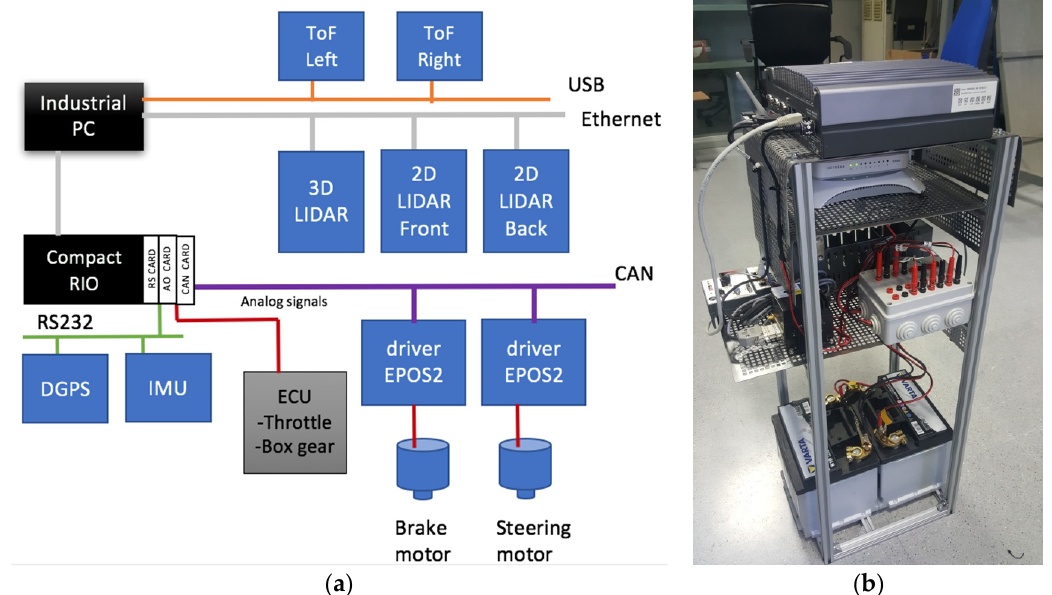
Figure 2. ( a ) Low ‐ level architecture; ( b ) rack to host the control and decision making systems.